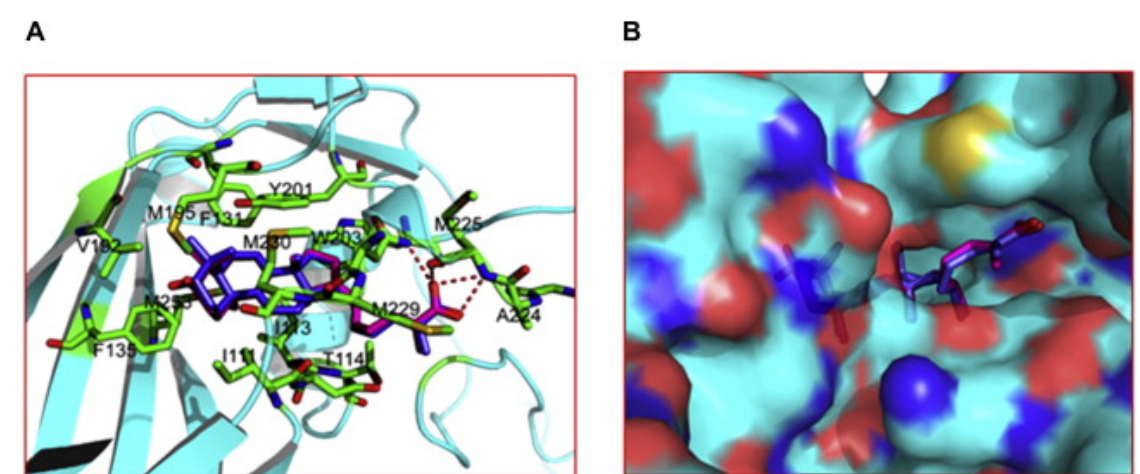
Figure 5. Molecular docking for the interaction of antiviral compounds with EV71 capsid. ( A ) Stick conformer diagram. ( B ) Cartoon conformer diagram. Both GLTA and GLTB could bind stably in the viral capsid mainly through hydrophobic interactions at a hydrophobic pocket (F site) in the capsid of EV71 virion. Source: Reprinted with permission from Zhang et al. [79]. 2022, Elsevier.